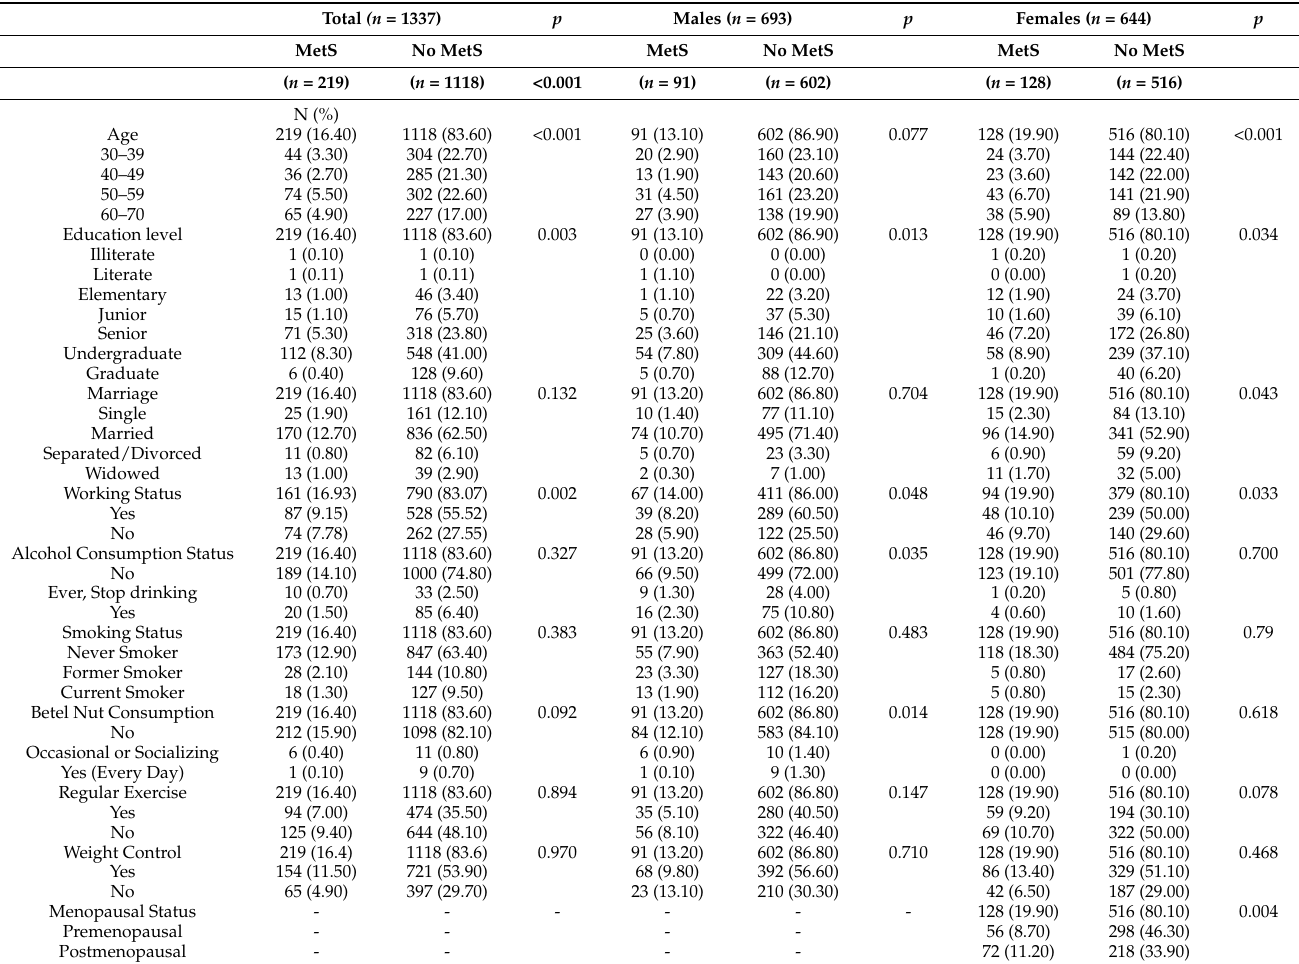
Table 1. Overall population characteristics and population characteristics stratified by sex and metabolic syndrome status among adults aged 30–70 years ( n =